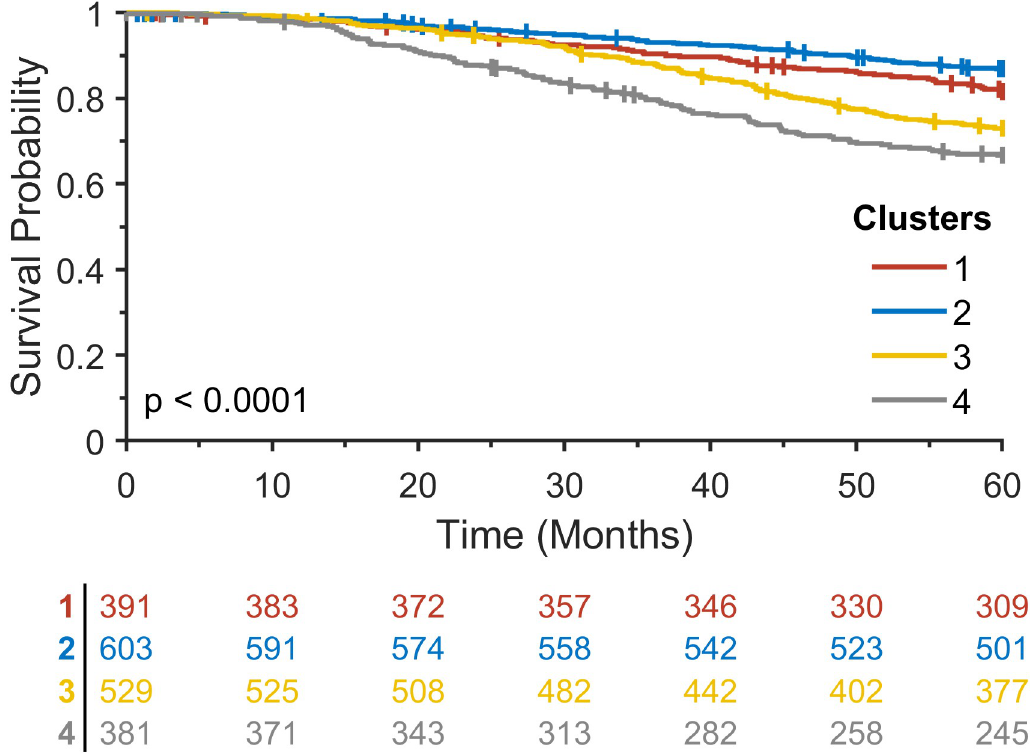
Fig 3. Kaplan-Meier analysis for four clusters that resulted from a hierarchical clustering method on the vector-valued Wasserstein distance matrix in the METABRIC study.